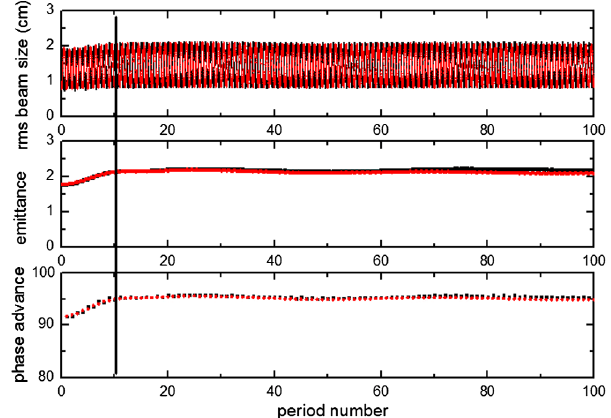
FIG. 2. Instability diagram of the envelope for tune depression η ¼ 0 . 8 . (Red, up threshold; blue, down threshold; black, work points.) FIG. 3. Plot of the rms beam size, emittance, and phase advance evolutions for σ ¼ 87 ° with the period number. (Black, x direction; red, y direction.)